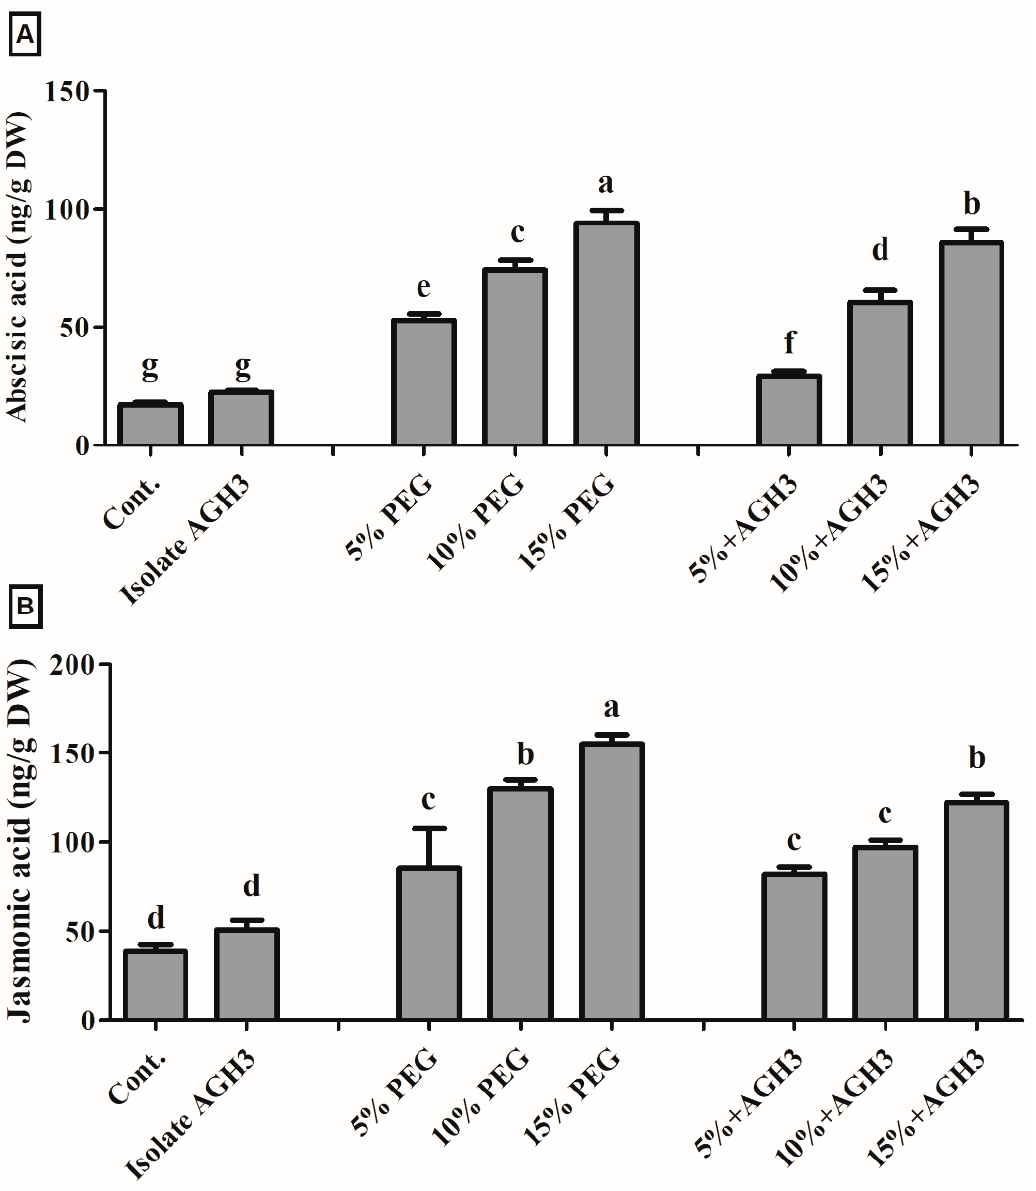
Figure 4. Effect of AGH3 on S. lycopersicum plant endogenous: ( A ) Abscisic acid (ABA); ( B ) jasmonic acid (JA). Different letters in the column show that values are significantly different ( p < 0.05) from each other as evaluated from the DMRT test.